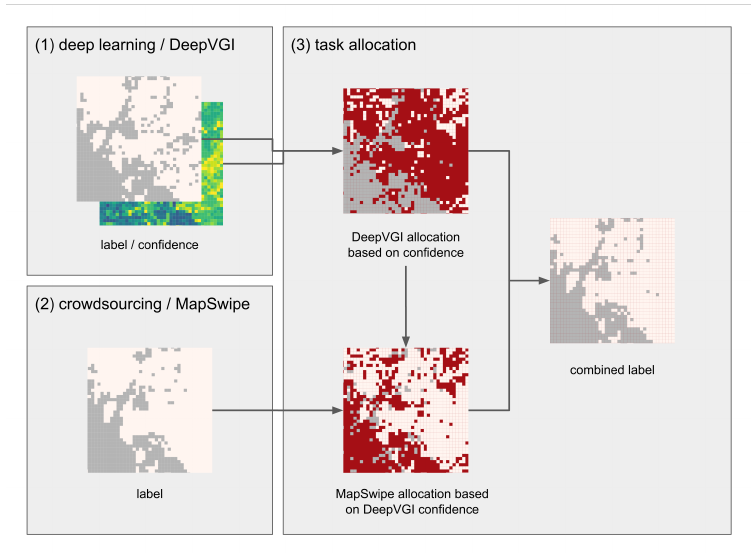
Figure 1. Proposed workflow to combine deep learning and crowdsourcing methods: Combined labels are obtained, by choosing labels either from DeepVGI or MapSwipe based on the confidence of the DeepVGI